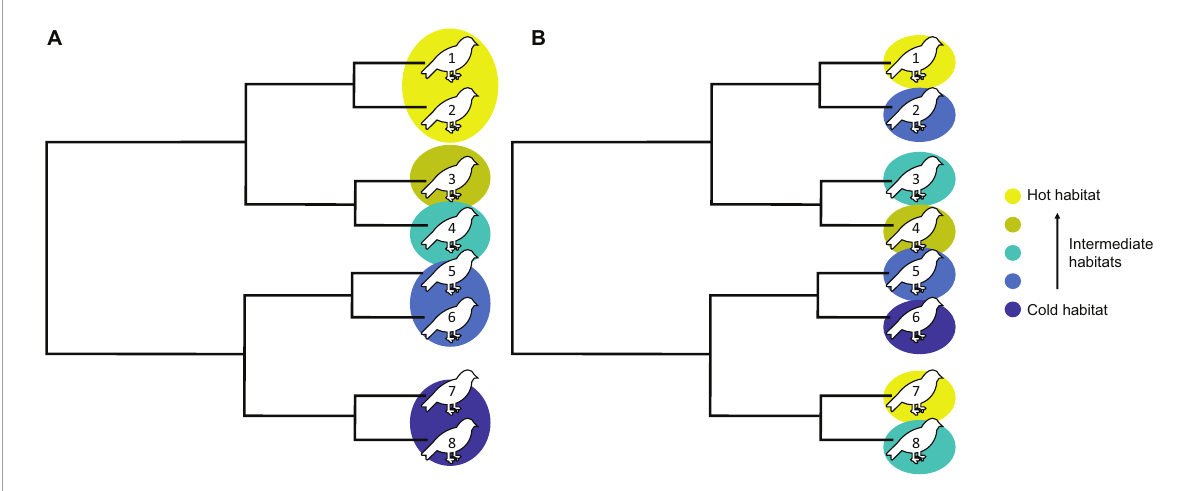
FIGURE1 Illustration of two hypothetical phylogenies and species distribution in three different habitats. Eight species (numbered 1–8 on the bird sign) in the final community distribute in five habitats across an environmental gradient (e.g., temperature). For simplicity, each species can only appear in one habitat. In scenario (A) , closely related species inhabit similar environment, leading to high phylogenetic beta diversity among different environments. Empirical research commonly interpreted this pattern as the presence of environmental and geographical barriers. In scenario (B) , species evenly distribute across habitats with different environments, increasing the shared evolutionary history among habitats. This leads to a lower phylogenetic beta diversity across the environmental gradient. There can be multiple processes underpinning such a pattern, but without an understanding of the moderating mechanisms, it is not possible to interpret the patterns in the context of assembly